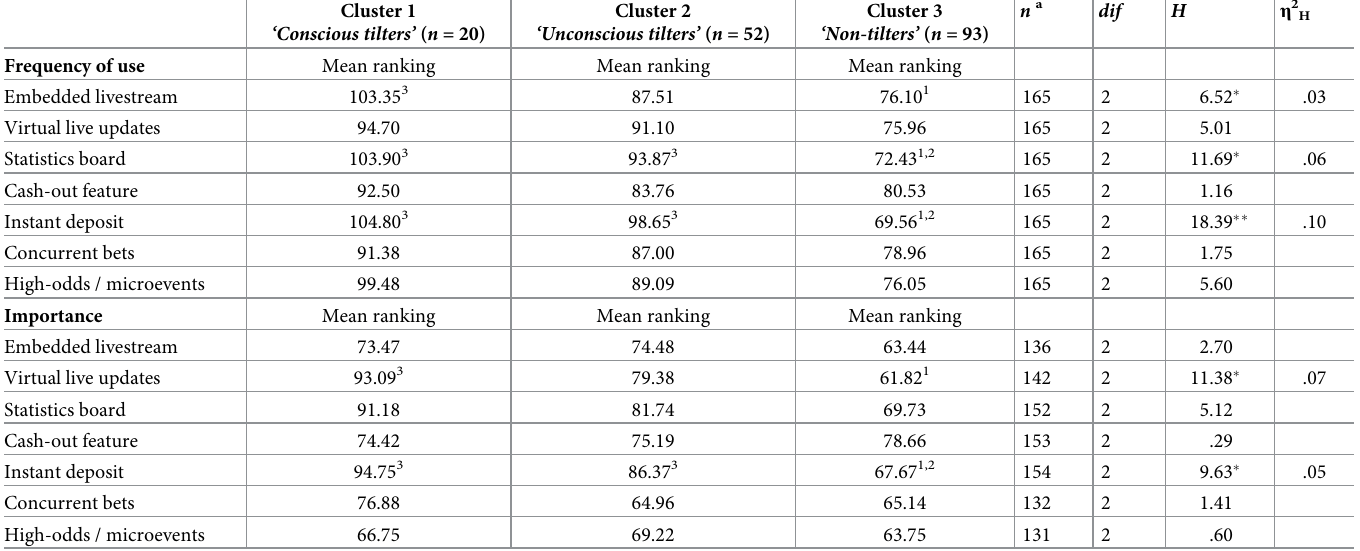
Table 4. Kruskal-Wallis H tests of product preferences between